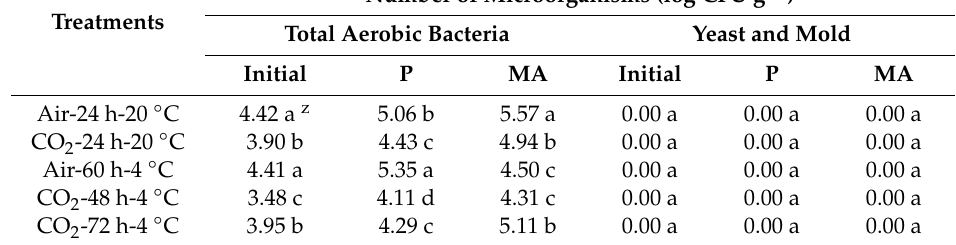
Table 4. The growth of microorganisms (Total aerobic bacteria, yeast and mold) of green asparagus treated with 60% CO 2 on the initial and final storage days in P (the 25th day) and MA (the 30th day) packages.